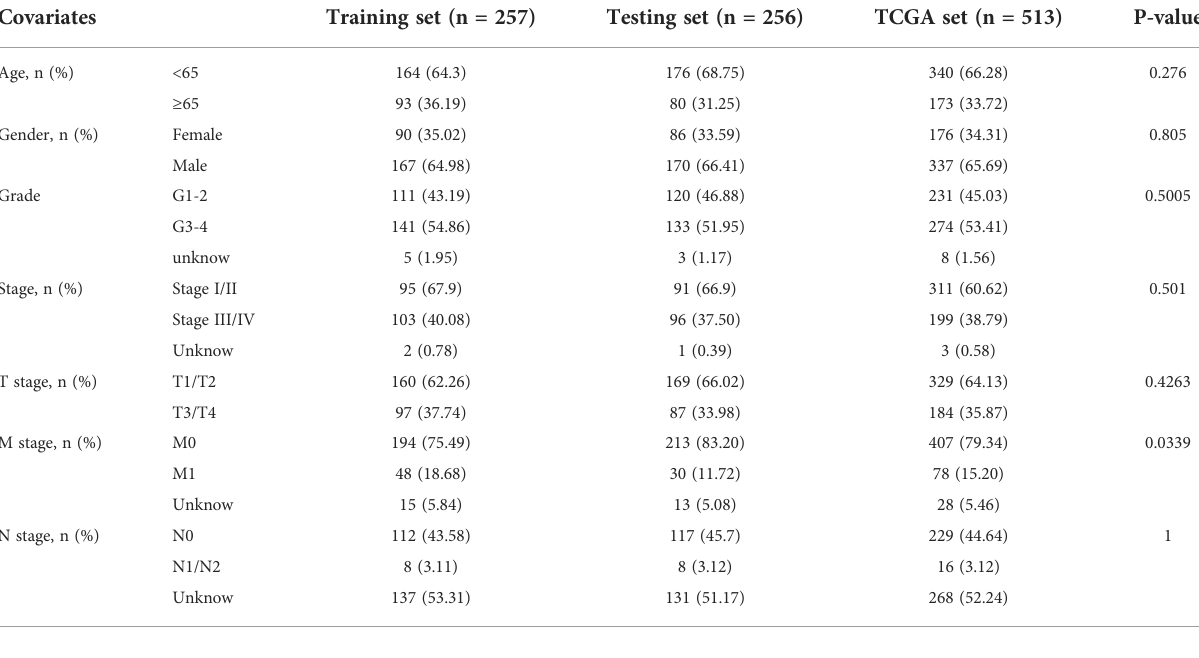
TABLE 1 Clinical information for three sets in ccRCC patients.